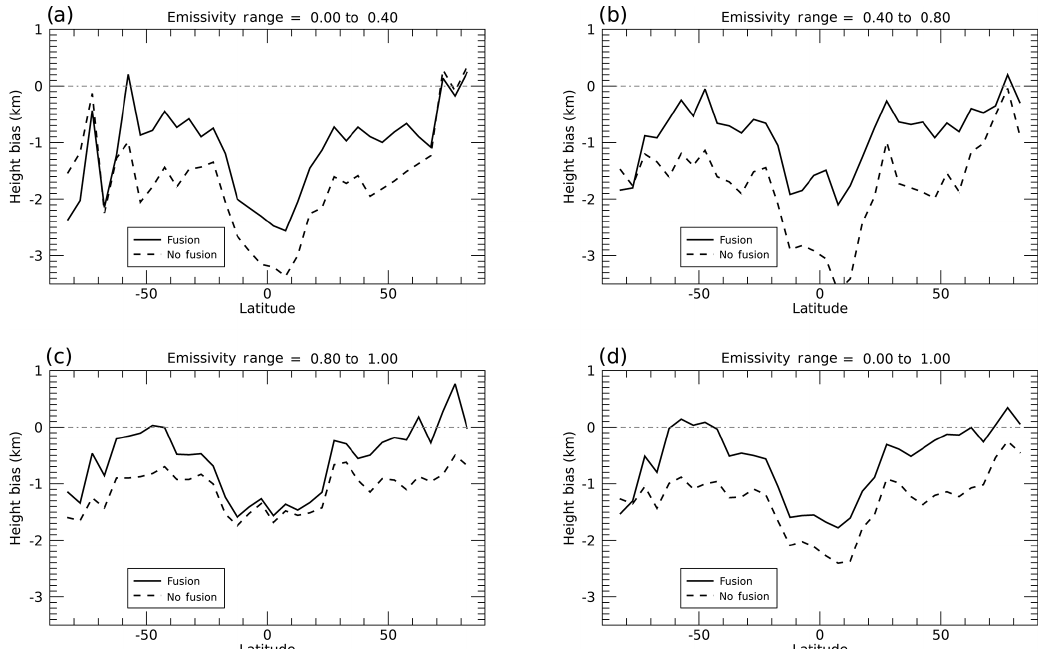
Figure 8. Zonal distribution of cloud height biases between S-NPP VIIRS and CALIPSO/CALIOP for emissivity ranges of (a) 0 to 0.4; (b) 0.4 to 0.8; (c) 0.8 to 1.0; and (d) 0 to 1.0. Solid and dashed lines indicate data with and without fusion channels. Both 6.7 and 13.3µm fusion channels are used for the fusion